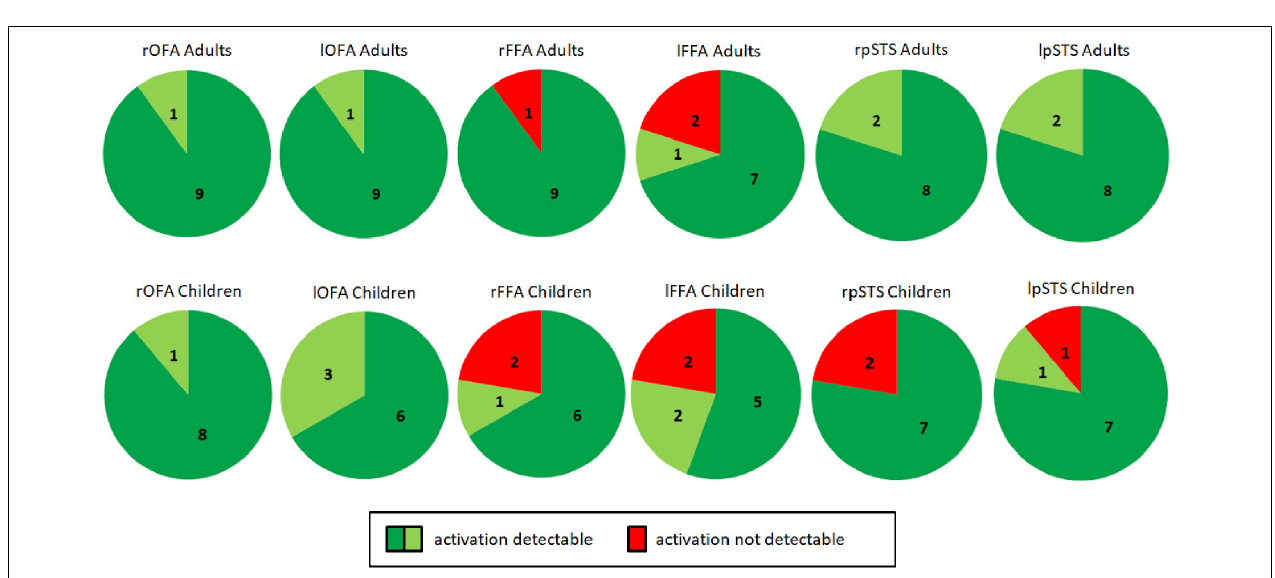
FIGURE 5 | Identification of bilateral OFA, FFA, and pSTS in adults ( top , n = 10) and children ( bottom , n = 9). Dark green indicates activity detectable at a statistical threshold of p < 0.05, FWE corrected for multiple comparisons at the whole brain level. Light green indicates activity detectable at a statistical threshold of p < 0.001/ p < 0.05 uncorrected. Red indicates no detectable activity. In all adults, brain activity could be detected in the right and left OFA as well as in the right and left pSTS. Activity could not be detected in the right FFA for one subject (A02) and the left FFA for two subjects (A02, A07). This was caused by the positioning of the measured volume (see section “Discussion”). As for adults, in all children brain activity could be detected in the right and left OFA. Activity was not detected for two children in the right pSTS (C04, C06) and for one child in the left pSTS (C04). Activity was also not detected for two children in the right FFA (C07, C08) and for two children in the left FFA (C01, C08). Missing FFA activity was again caused by the positioning of the measured volume. OFA, occipital face area; FFA, fusiform face area; pSTS, posterior superior temporal sulcus; l, left; r, right.